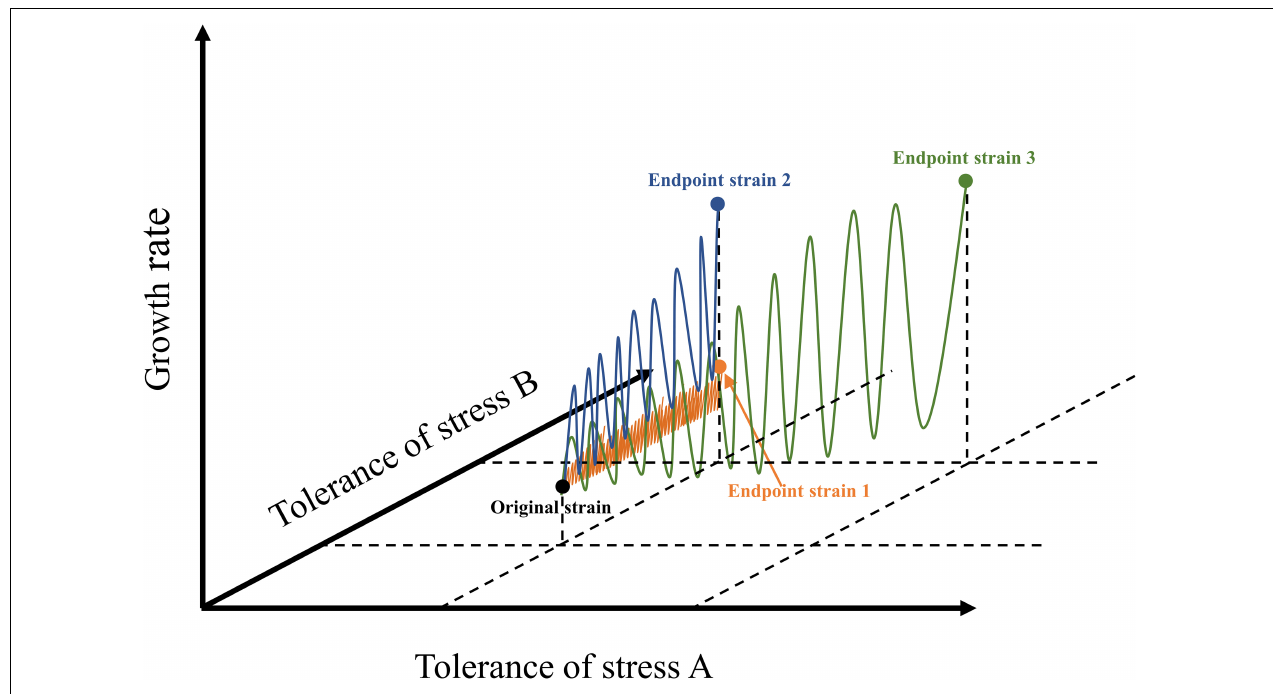
FIGURE 1 | Schematic diagram of different microalgal ALE approaches. The blue line represents ALE pattern of microalgae under appropriate stress concentration; the orange line indicates the ALE pattern of microalgae under low stress concentration; the green line represents the possible ways in which ALE of microalgae could be applied to two stress conditions simultaneously. This figure was modified according to the research (Zhao and Huang,